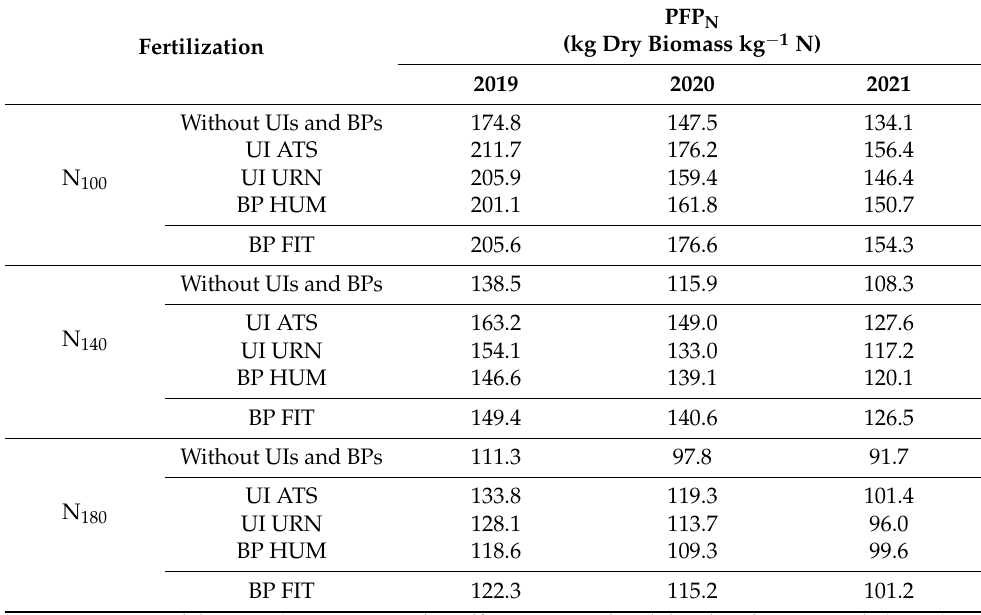
Table 9. Agronomic indices of nitrogen use efficiency dry biomass yield of maize for 2019–2021.